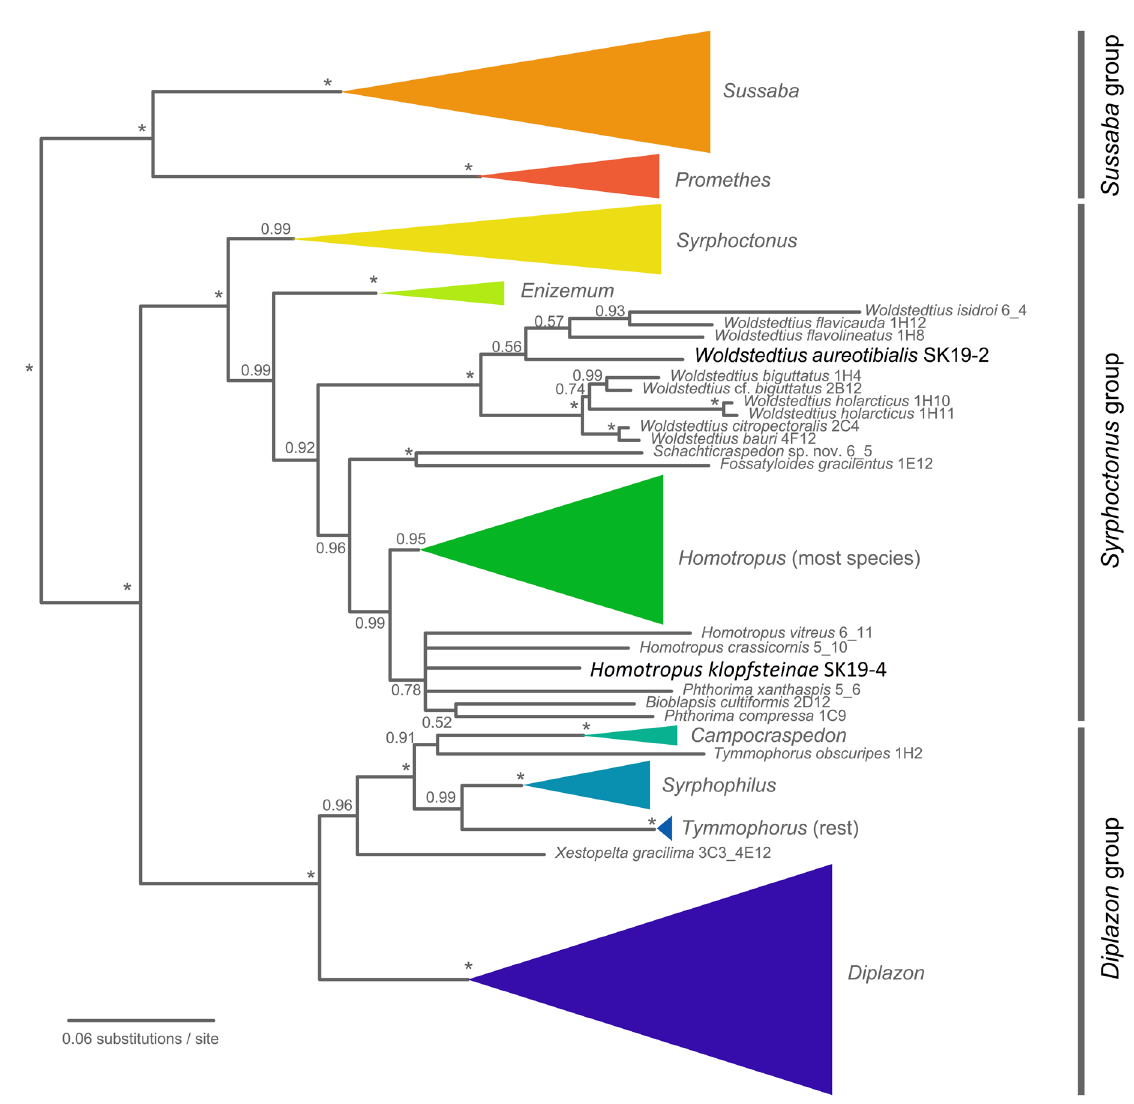
Fig. 1. Bayesian phylogenetic reconstruction based on a four-gene dataset from Klopfstein et al . (2011). The two new taxa Homotropus klopfsteinae sp. nov. and Woldstedtius aureotibialis sp. nov. were included in the dataset by their barcoding region (CO1). Values next to nodes are posterior probabilities, with asterisks representing maximum clade